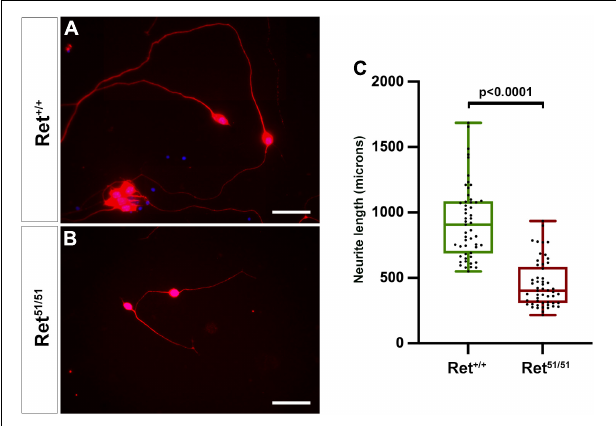
FIGURE 4 | Neuritogenesis is compromised in Ret 51 / 51 neurons maintained in culture. (A,B) Cultures of enteric neurons from gut of control ( Ret + / + ) and Ret 51 / 51 embryos immunostained for TuJ1 (red). (C) Graph showing the average neurite length of control ( Ret + / + ) and Ret 51 / 51 neurons from gut cultured for 6 days. Ret 51 / 51 neurons have significantly shorter processes. Embryos from 3 litters of E11.5 Ret + / 51 heterozygous crosses were analysed. ( n = 6 for each genotype; 53 axons each). Scale bar: 200 µ m. Statistical analysis performed by Welch’s t